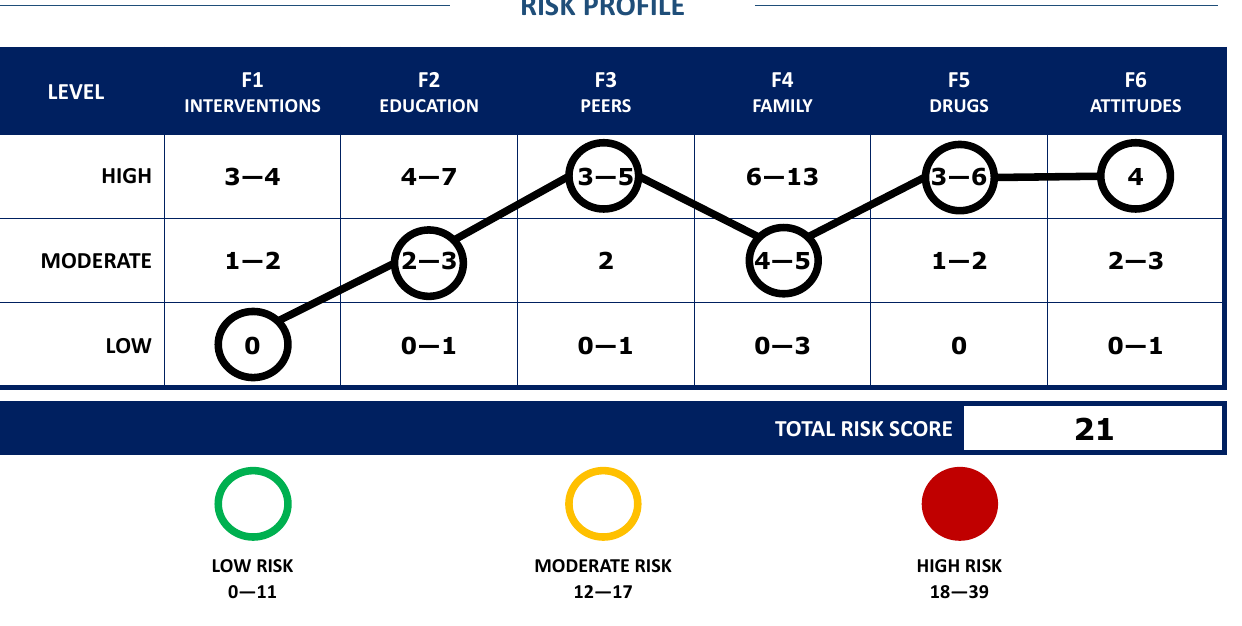
Figure 1. Example for presentation of results in the FER ‐ R risk profile.